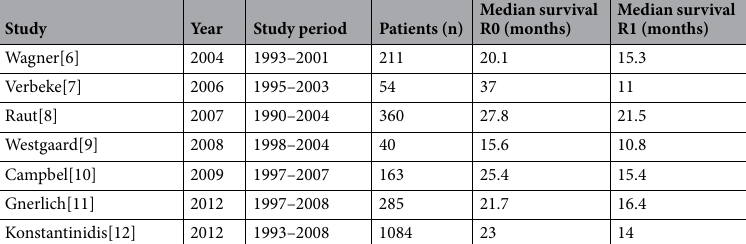
Results Multiphoton images of normal pancreatic tissues. Normal pancreatic duct . Figure 1 shows MPM images and the corresponding H&E-stained image of normal pancreatic duct. As shown in Fig. 1(a), the collagen around the duct and the individual duct could be detected by TPEF signals. In position 1, the duct presented the